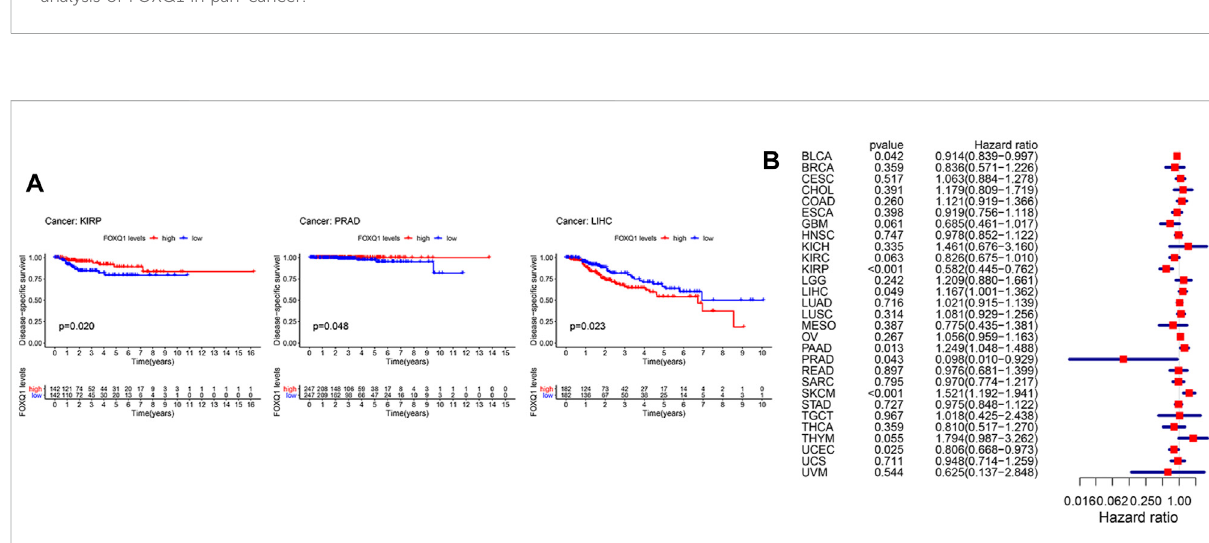
FIGURE 3 Association of forkhead box Q1 (FOXQ1) expression with disease-speci fi c survival across different cancer types. (A) Kaplan – Meier curve based FOXQ1 expression in cancer. The red color represents high expression, and the blue color represents low expression. (B) forest plot for the disease- speci fi c survival analysis of FOXQ1 in pan-cancer.